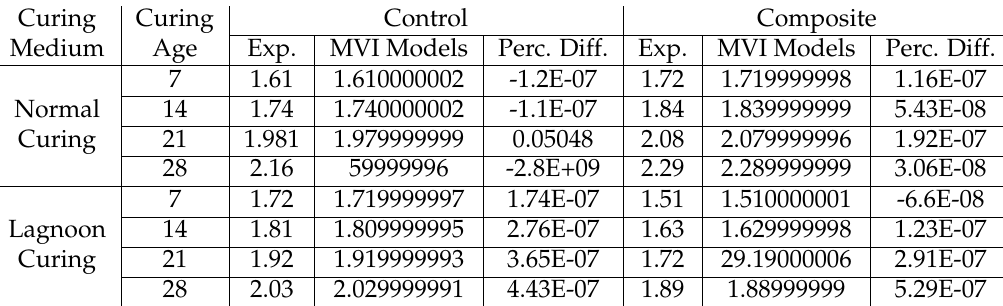
Table 7. Validation of developed mathematical models for the split tensile strength of pozzolan blended steel slag aggregate concrete using MVI